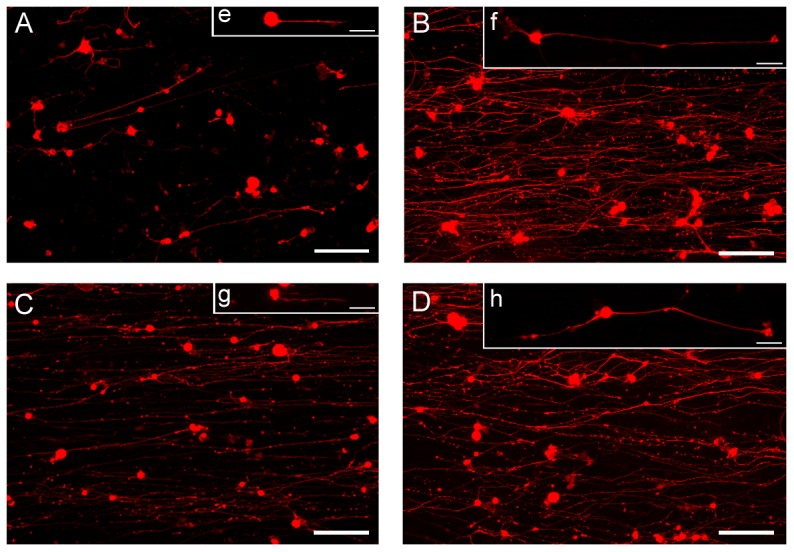
Bioactivity of functionalized electrospun fibroin nanofibers on DRG neurons growth.DRGs cells were seeded on either unfunctionalized (A and e), NGF-functionalized (B and f), CNTF (C and g) or NGF and CNTF-functionalized nanofibers (D and h) and neurons were stained with anti BIII tubulin antibody. Fluorescence images were acquired after 5 days of culture (A, B, C and D). Higher magnification of individual growing neurons (e, f, g and h) were acquired 3 days after seeding, to prevent overlapping of neurons currently observed after a longer time in culture. For details see material and methods. Scale bars: A, B, C, D: 100µm; e, f, g, h: 20 µm.